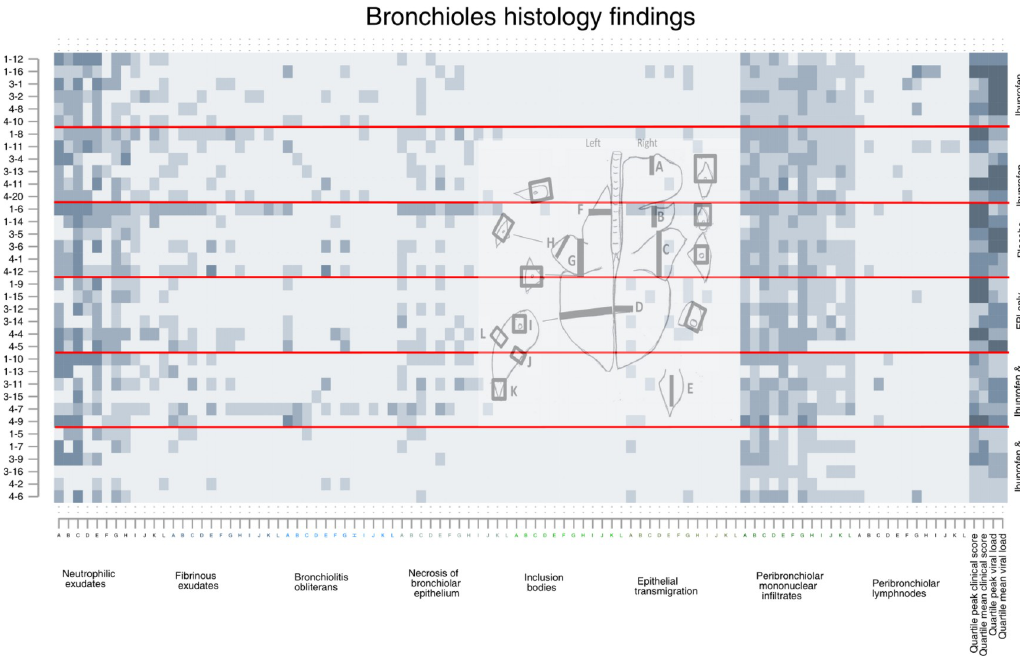
Fig 4. Bronchiole histology findings by drug treatment group. Each row represents an individual calf, each letter represents a slide, the x-axis colors indicate a different specific histological finding. The shading of each pixel represents the severity of the finding on a scale of 0 (light) to 3 (darker). On the y-axis the first number represents the batch/replicate number, the number following the dash the ear tag for the individual calf. The horizontal red lines divide the treatment groups. The last four columns represent quartiles (first lightest, fourth darkest) of mean peak and clinical scores and mean peak viral loads measured by nasal swabs.